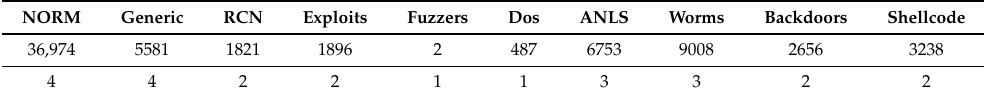
Table 8. Each attack type corresponds to the throughput